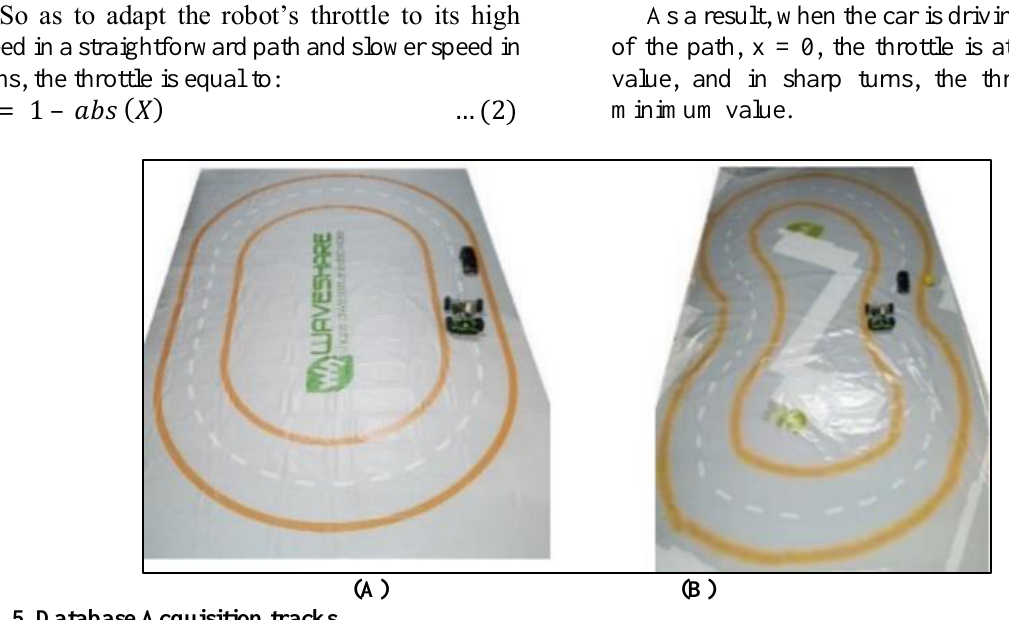
Fig. 5. Database Acquisition tracks